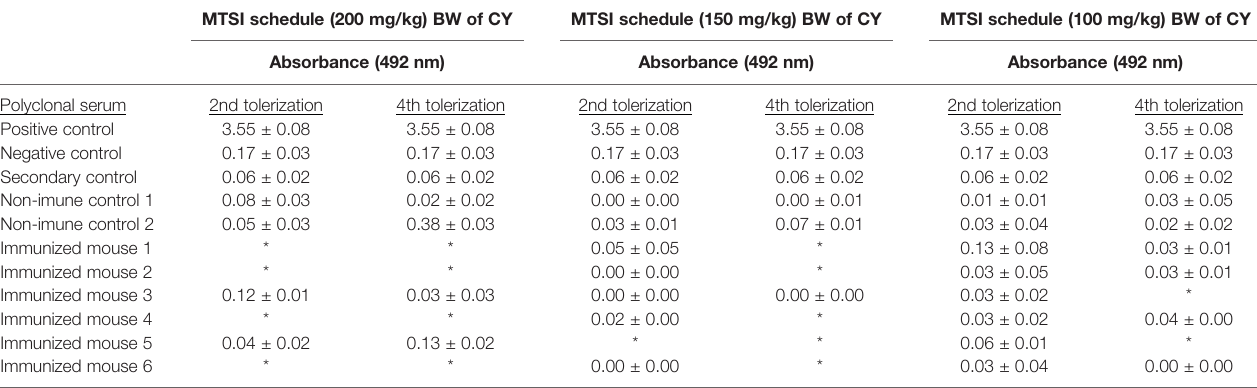
TABLE 1 | Whole-cell ELISA optical densities of pAbs from immune and non-immune mice serum against non-tumor prostate